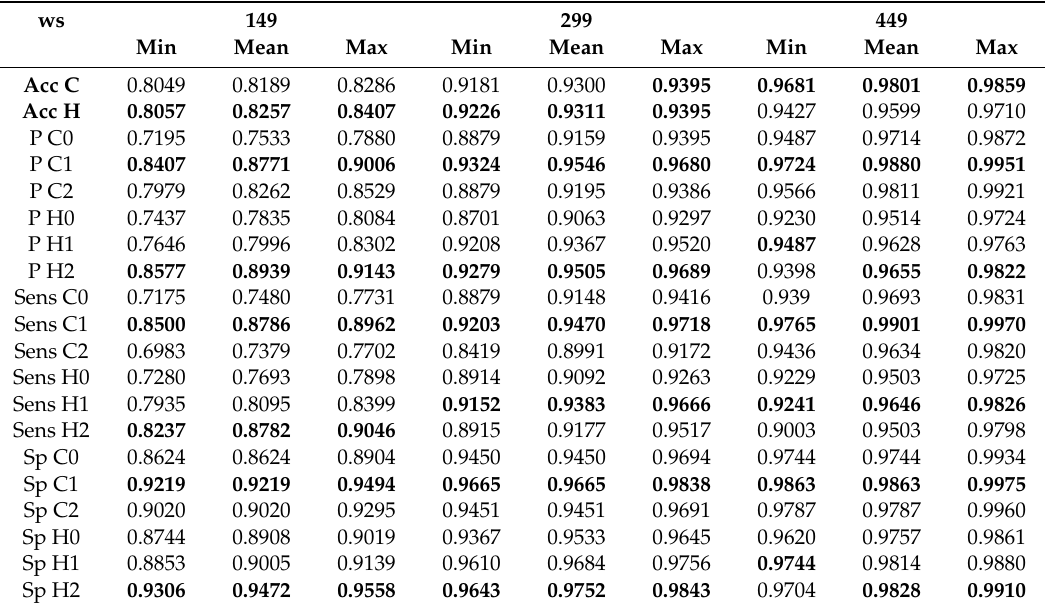
Table 4. Detailed statistical results of tremor level classification: accuracy (Acc), precision (P), sensitivity (Sens), and specificity (SP), using window sizes (ws) of 149, 299, and 449 for calculating contrast (C) and homogeneity (H) features.